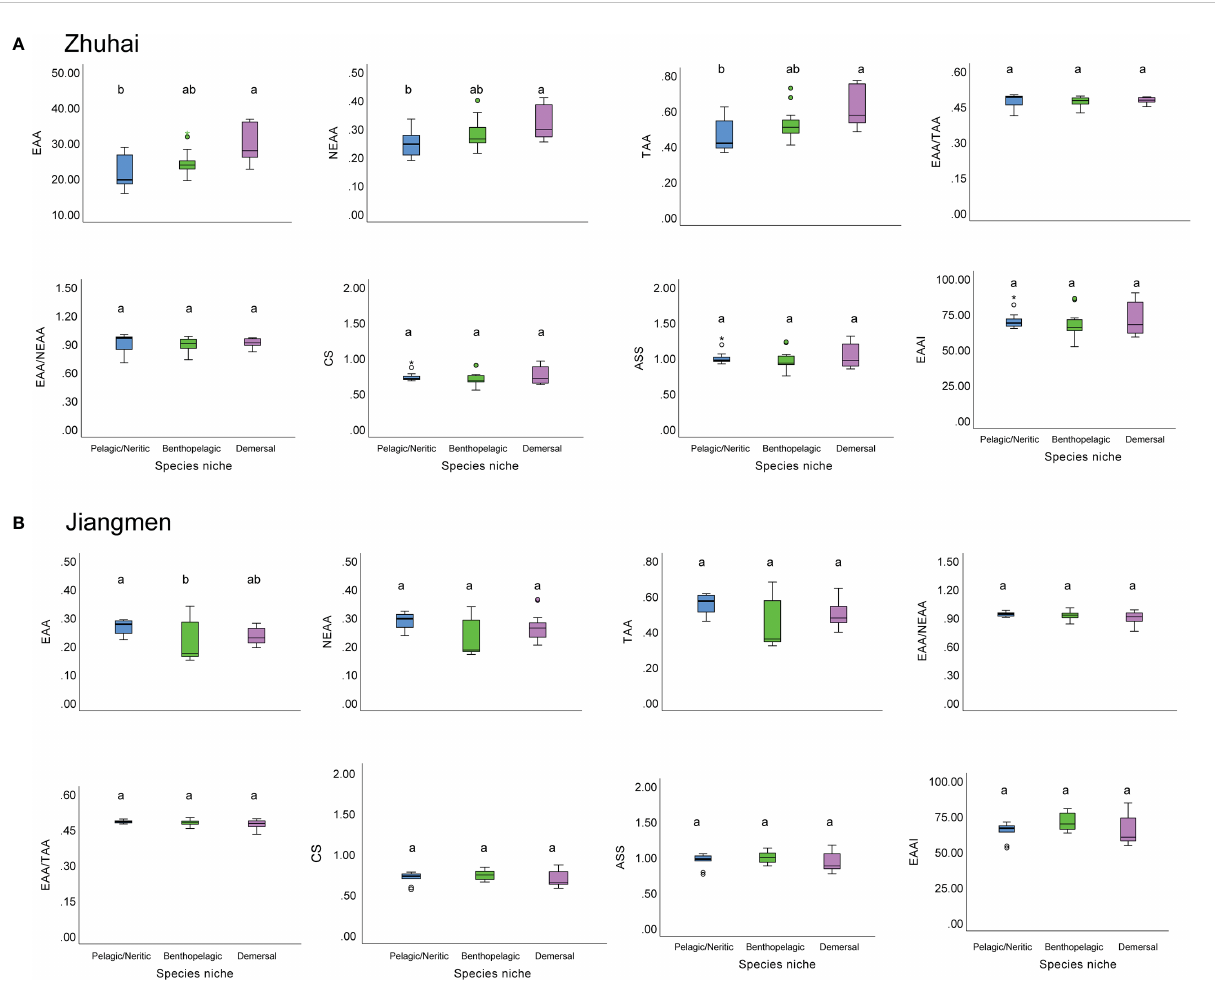
FIGURE 6 The box plots of amino acids composition of fi shes in different species niches from Zhuhai (A) and Jiangmen (B) . Different lower-case letters indicate a signi fi cant difference among